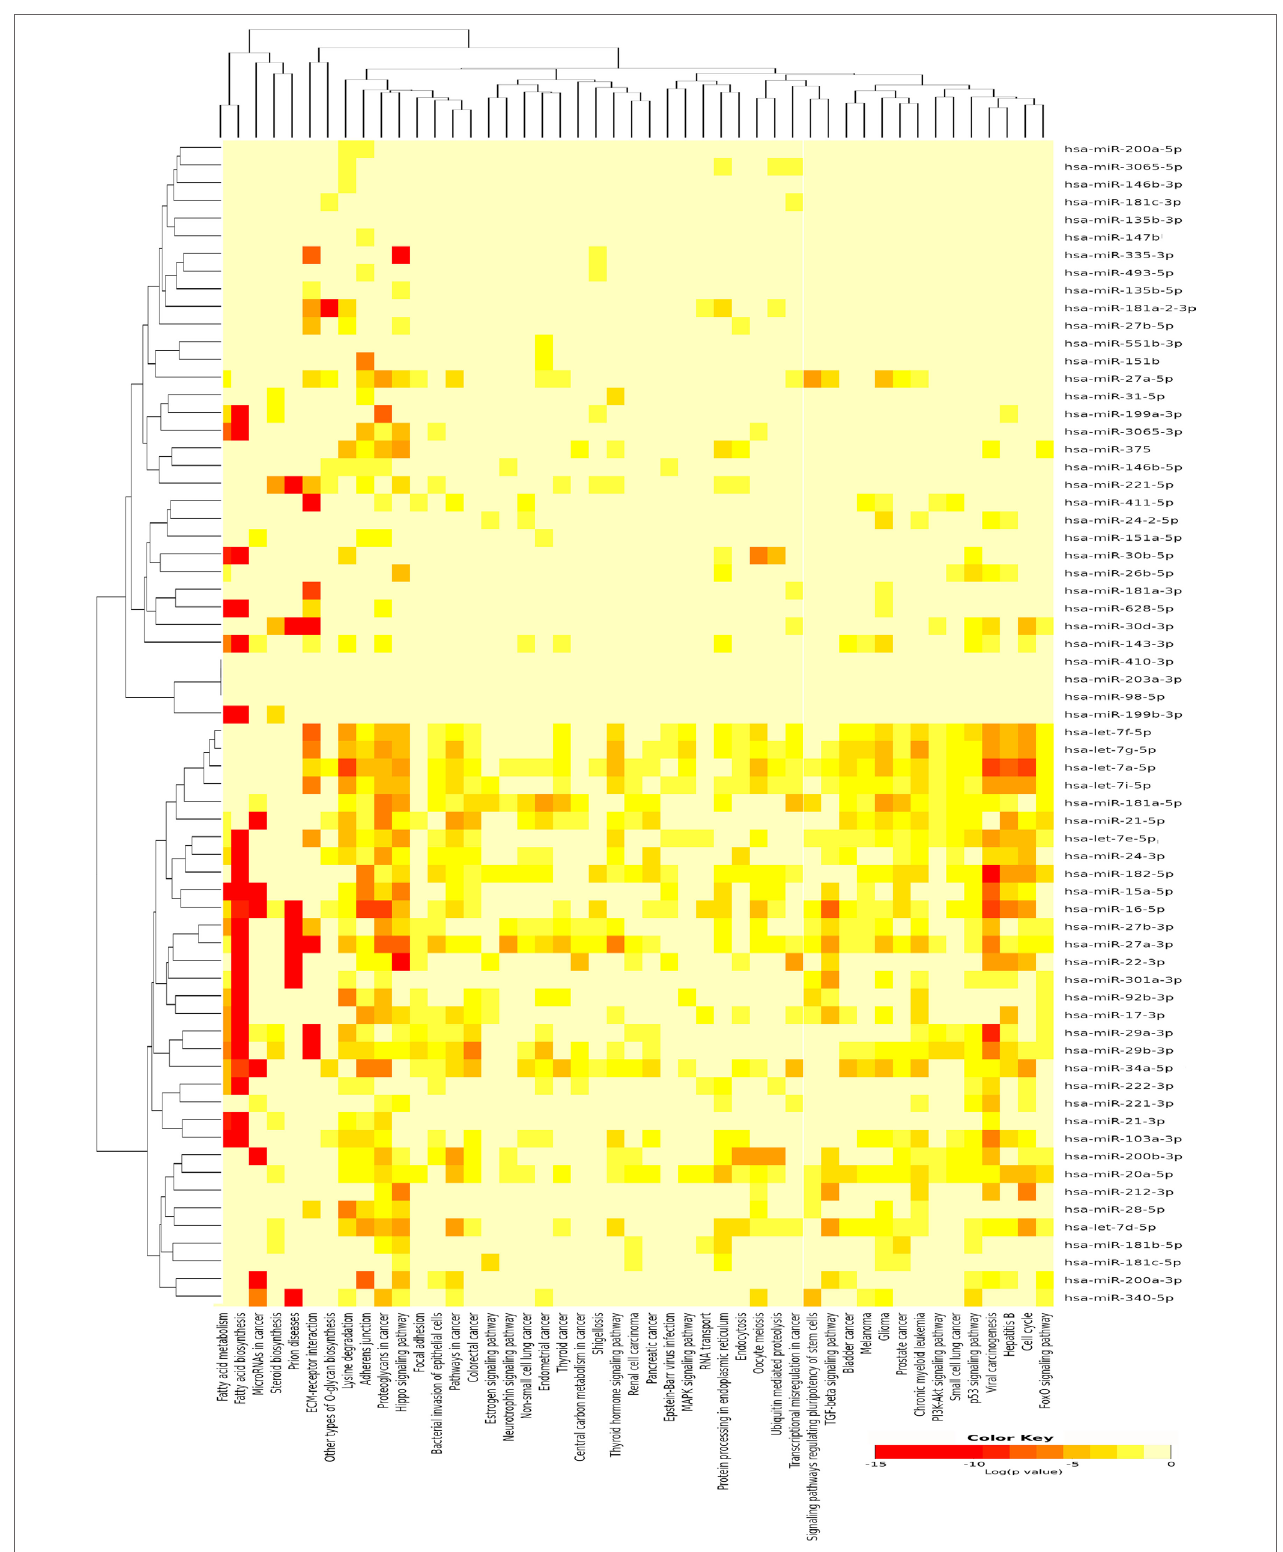
FigUre 3 | Pathway enrichment analysis on 66 upregulated microRNA (miRNA) in papillary thyroid carcinoma LNM-P and heatmap for miRNA versus pathway (clustered based on their significance value) using DIANA miRPath v3.0 software. Dendrogram on both axis represent hierarchical clustering resulting from miRNA and pathway. The miRNA were clustered together with similar pathway pattern and the pathways were clustered together based on related miRNAs.